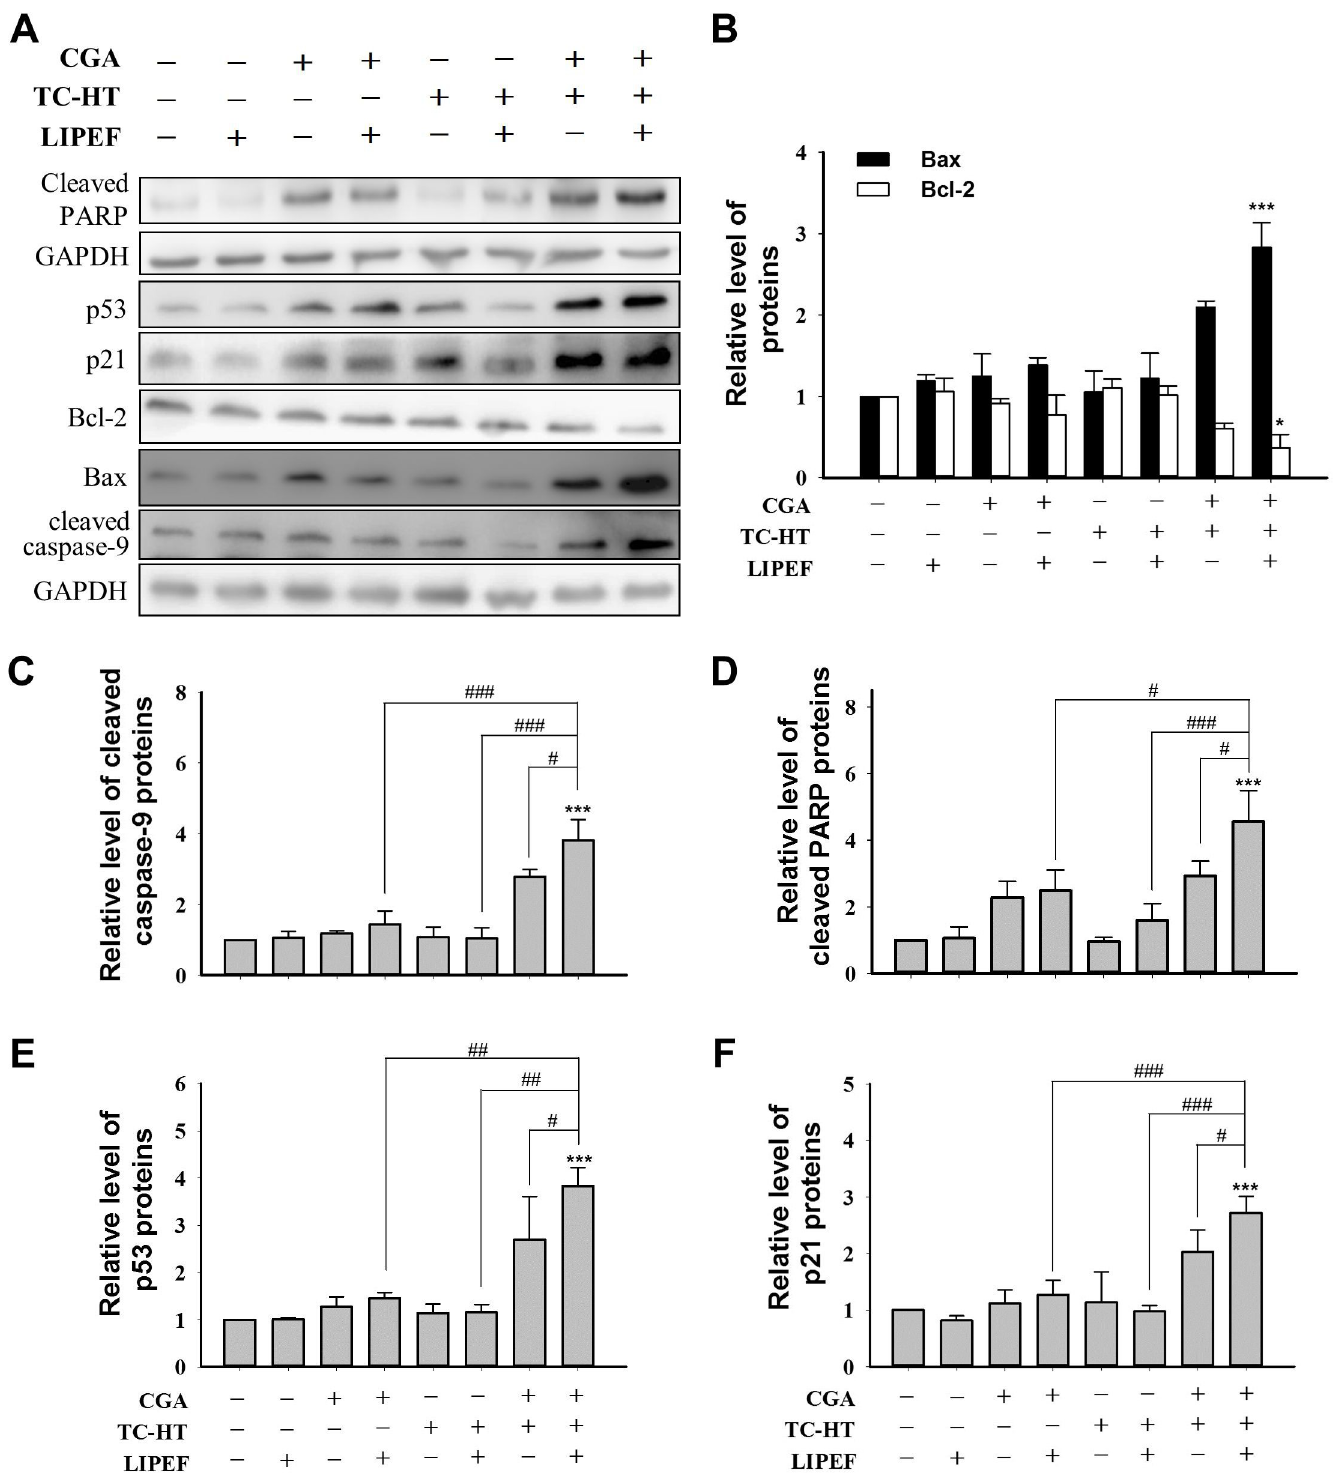
Fig 6. Effects of single, double or triple combinations of CGA, TC-HT, and LIPEF on the expression of p53-associated proteins in PANC-1 cells. (A) Representative images of western blotting and the quantification of (B) Bax and Bcl-2, (C) cleaved caspase-9, (D) cleaved PARP, (E) p53, and (F) p21 proteins of the PANC-1 cells treated with CGA (200 μ M), TC-HT (10-cycles), and LIPEF (60 V/cm) alone, in double or triple combination treatment for 24 h were examined by western blot analysis. GAPDH was used as internal control. Data are presented as mean ± S.D. in triplicate. ( � p < 0.05 and ��� p < 0.001 vs. untreated control; # p < 0.05, ## p < 0.01, and ### p < 0.001 between indicated groups).